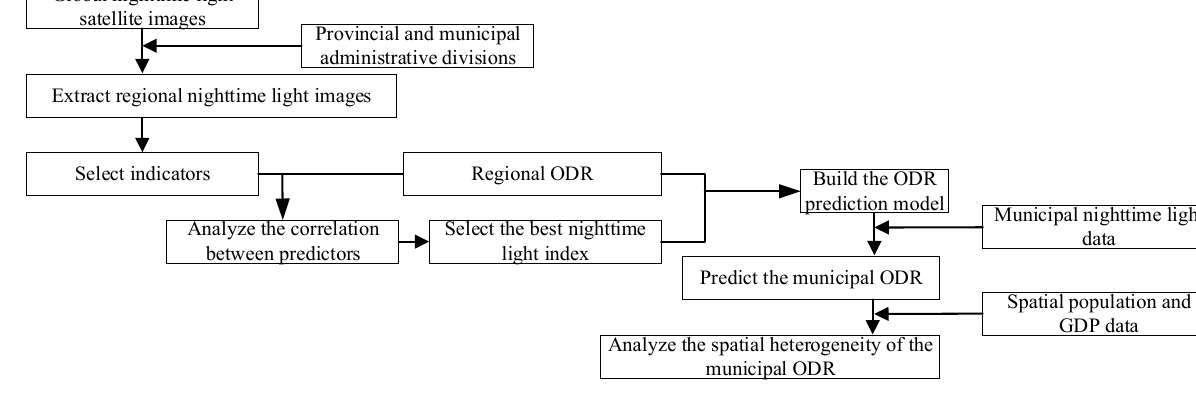
Figure 1. Flowchart of the research